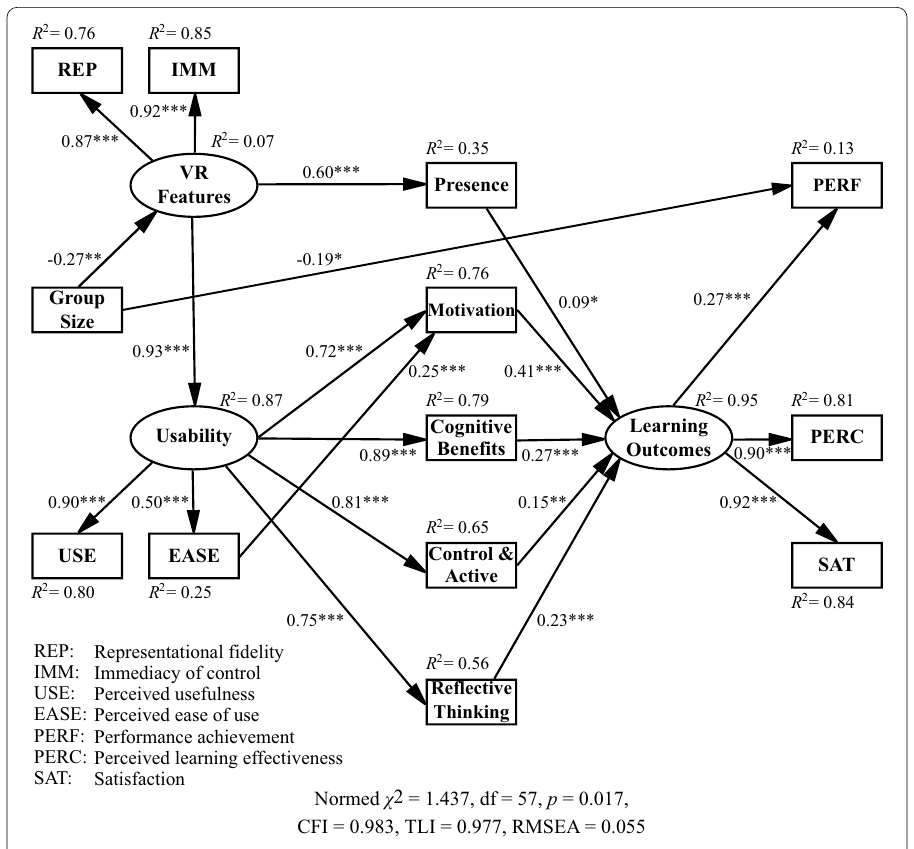
Fig. 4 Structural model showing hypothesized relationships, their standardized path coefficients and statistical significance, as well as the proportion of variance ( R 2 ) of the variables as explained by the model. * p < 0.05, ** p < 0.01, *** p <